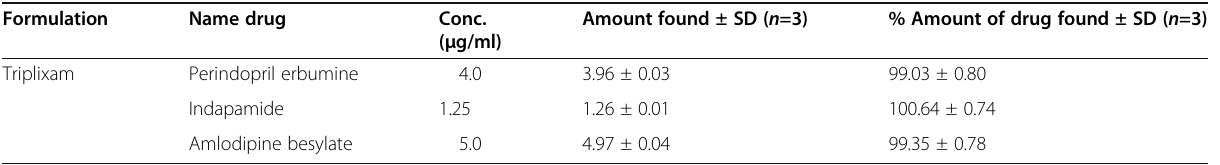
Table 5. Assay result of marketed formulation